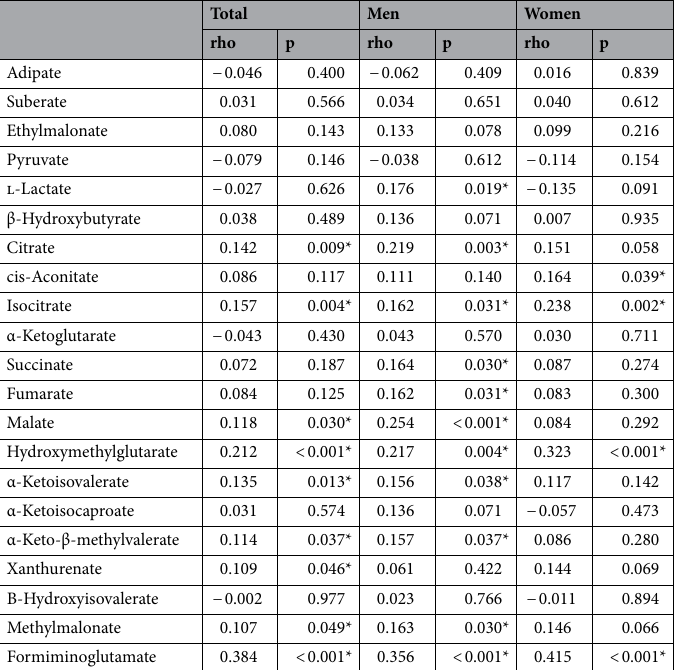
Table 2. The Spearman correlation coefficients of the levels of the metabolites with baPWV. BaPWW Brachial-ankle pulse wave velocity. Rho indicates Spearman correlation coefficients. *P < 0.05.